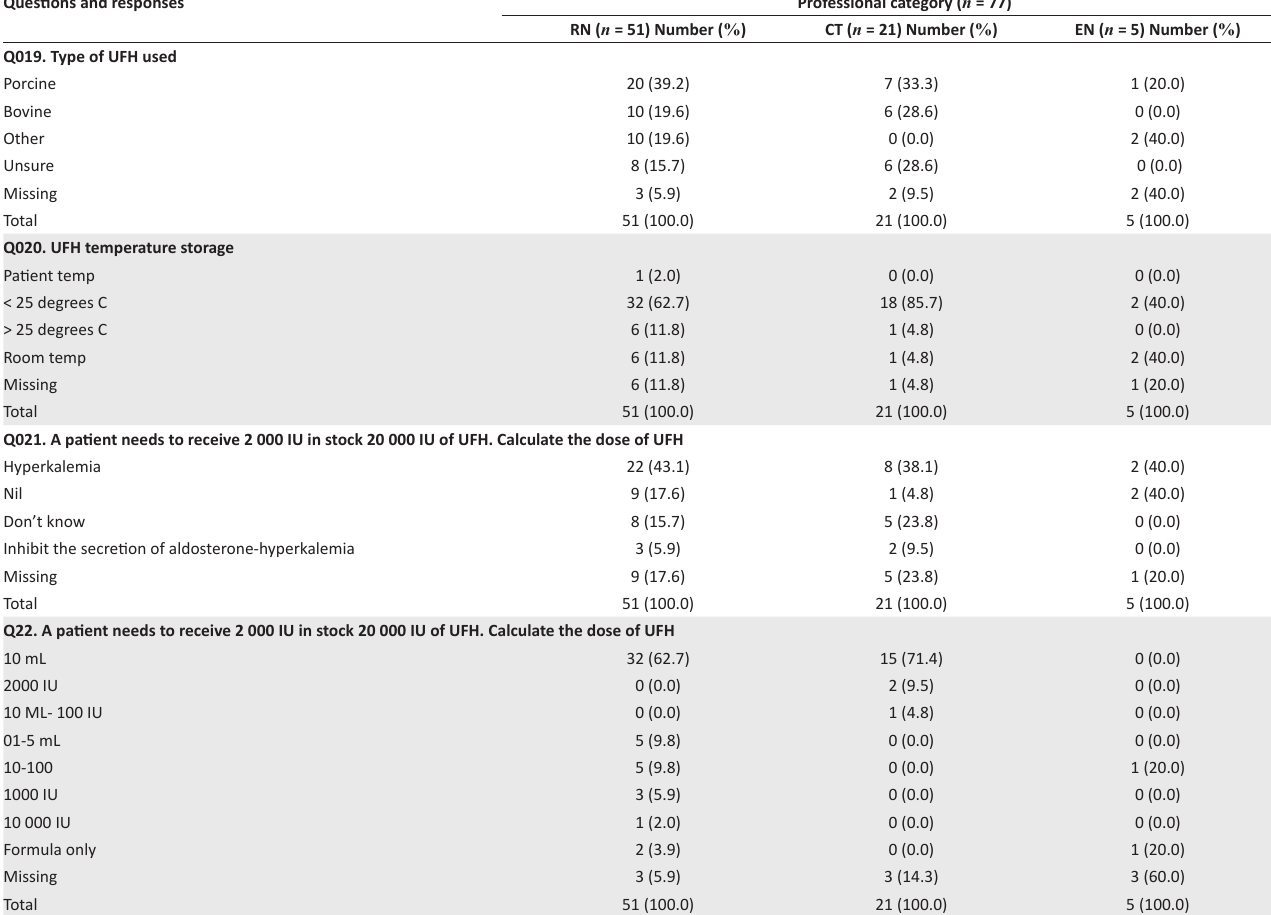
TABLE 1-A1 (Continues...): Respondents’ self-reported knowledge results by professional